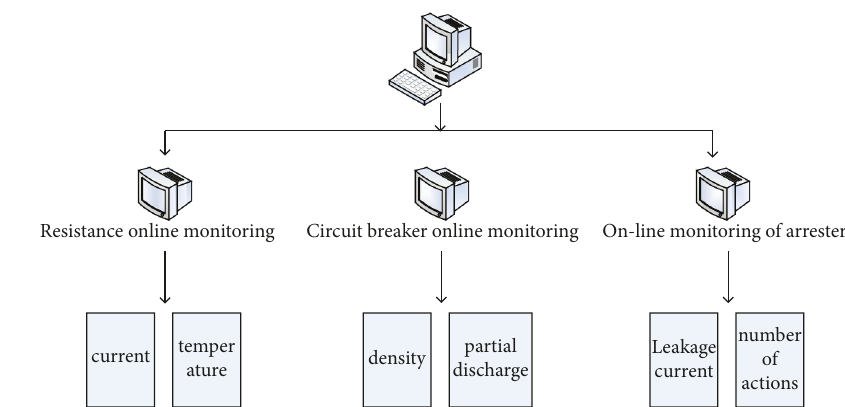
Figure 2: Safety monitoring system structure.